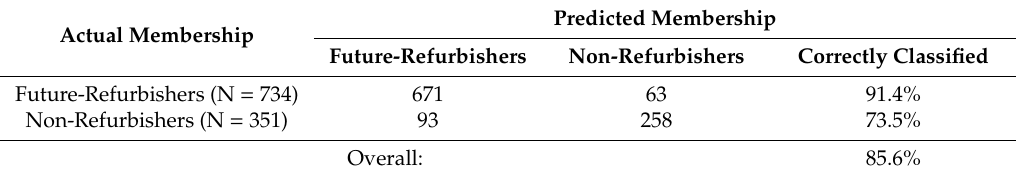
Table 4. Classification table showing the predicted and actual groups from the sample. Actual